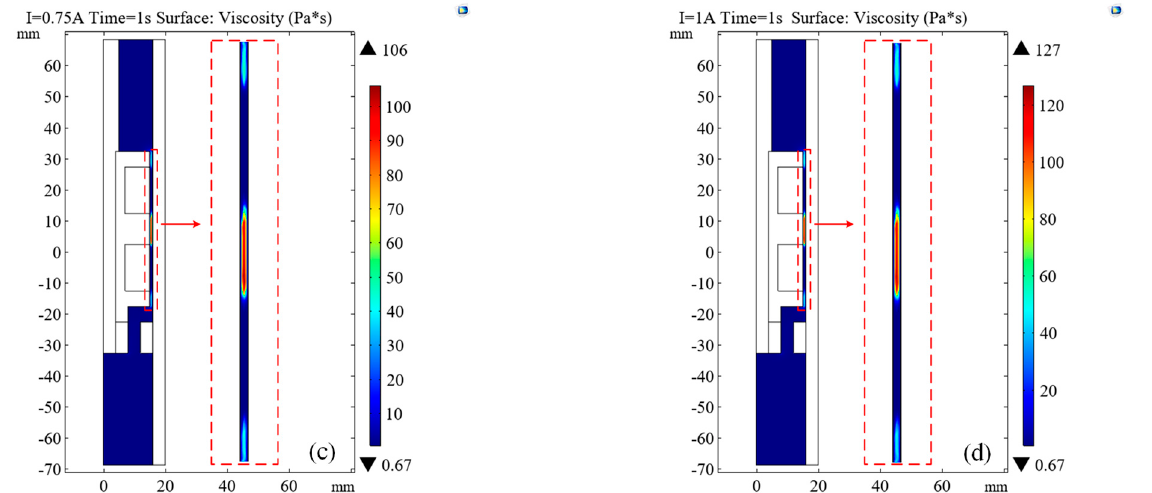
Figure 9. Dynamic viscosity distribution for: ( a ) I = 0.25 A; ( b ) I = 0.5 A; ( c ) I = 0.75 A; and ( d ) I = 1 A.